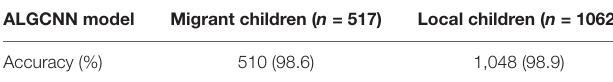
TABLE 2 | Classification results based on ALGCNN model.